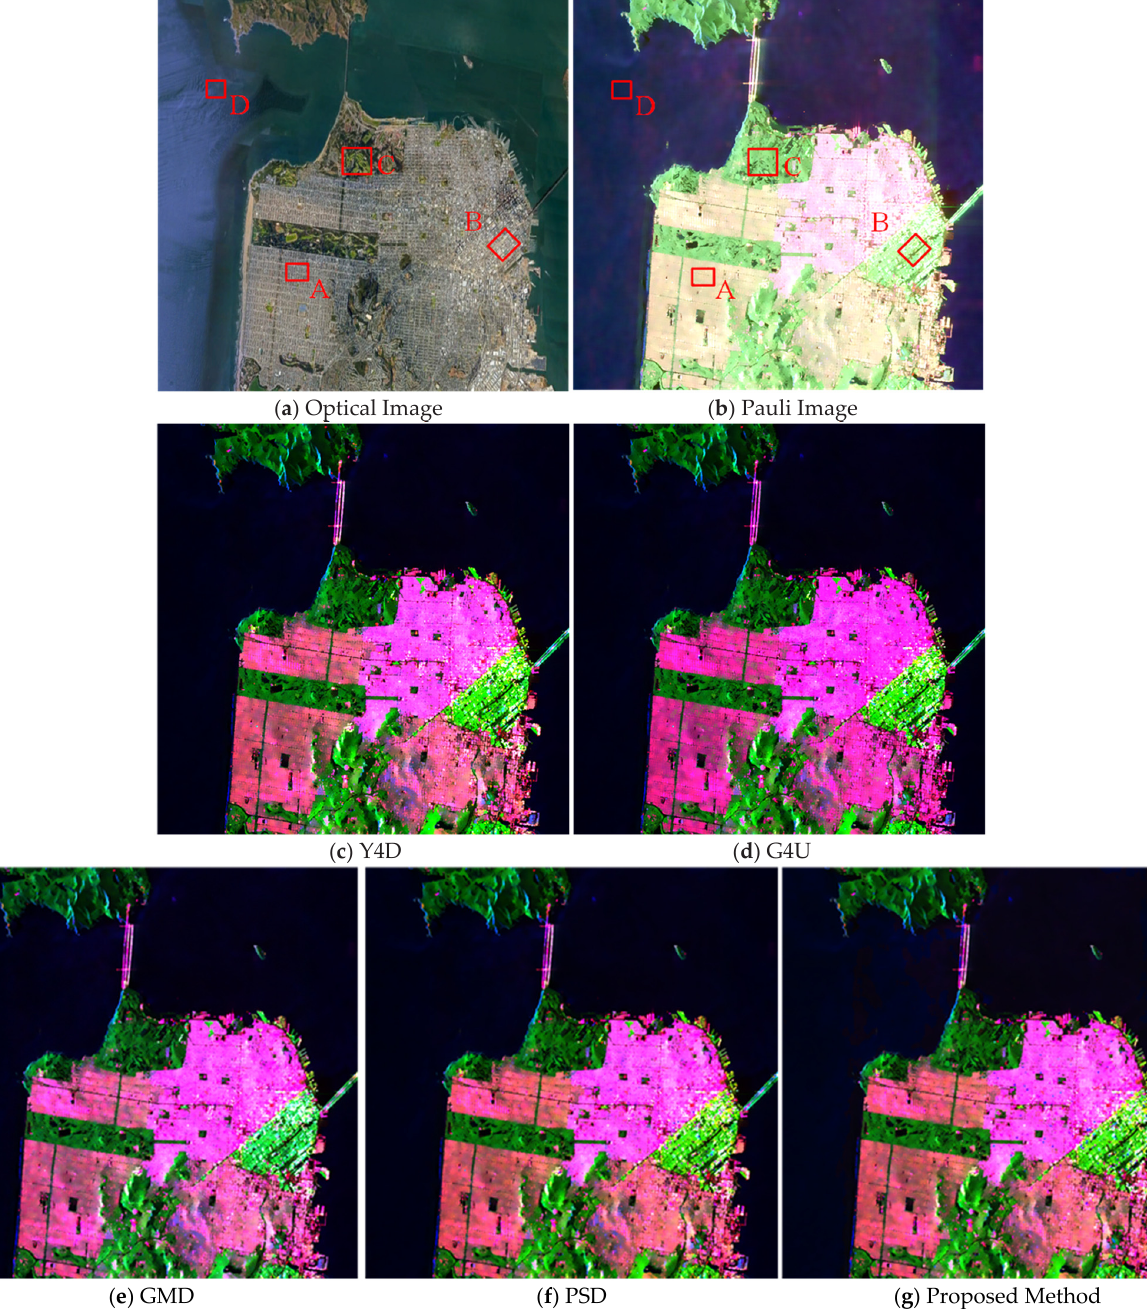
Figure 8. Decomposition results of ALOS-2 data. ( a , b ) are the optical and Pauli image. ( c – g ) are the decomposition result of different decomposition methods. The images are colored by Pd (red), Pv (green), and Ps (blue).